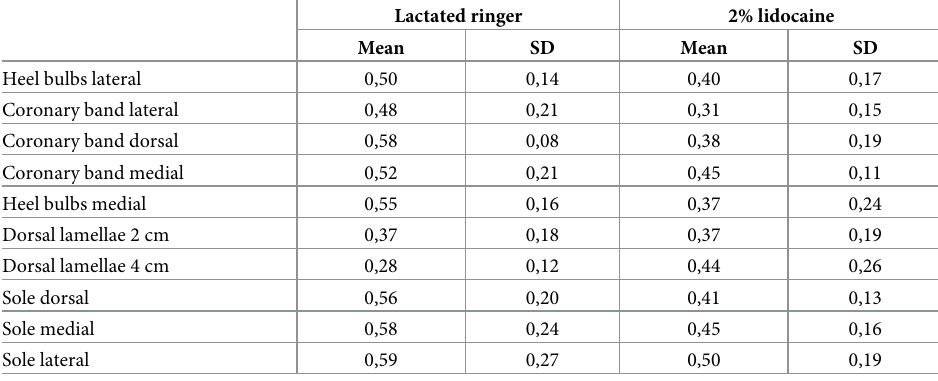
There was no statistical difference (P > 0.05) when comparing MNT of the control versus treatment group, between groups and times. The Wilcoxon test showed a difference between groups at baseline for the lateral coronary band times after anesthetic infiltration of the